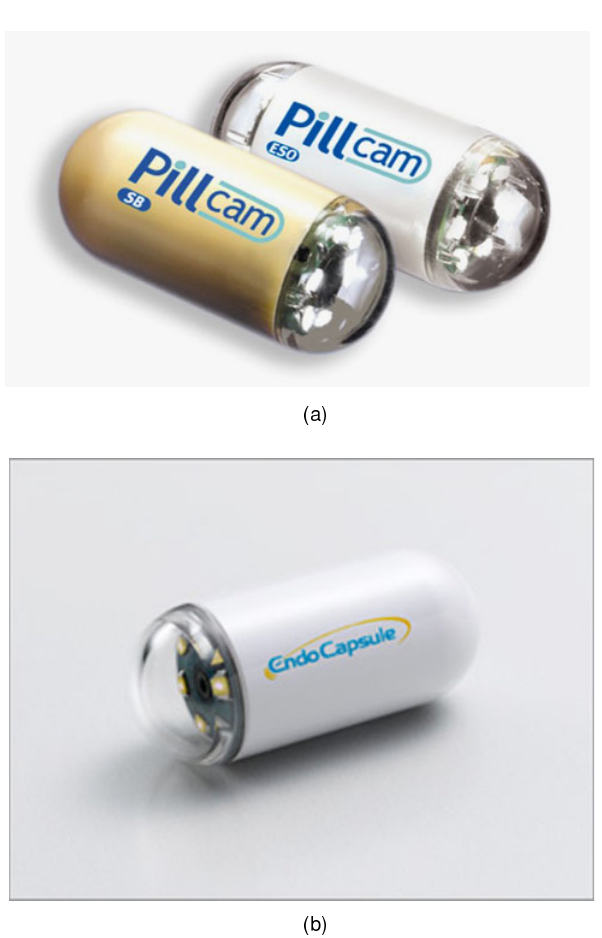
Figure 1 (a) PillCam (formerly M2A) developed by Given